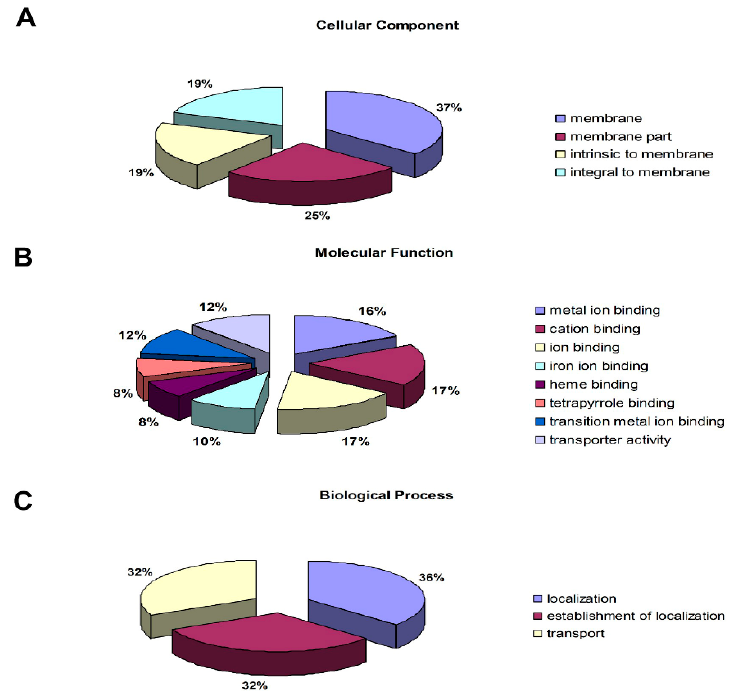
Figure 4. Functional categorization of the differentially-accumulated proteins between virus-infected and control M. persicae . The proteins were grouped based on GO annotations, and the percentages of proteins in each GO term are displayed for the Cellular Component ( A ), Molecular Function ( B ), and Biological Process ( C ) categories. Table 4. Significantly enriched KEGG pathways in the M. persicae proteome for aphids infected with cucumber mosaic virus.